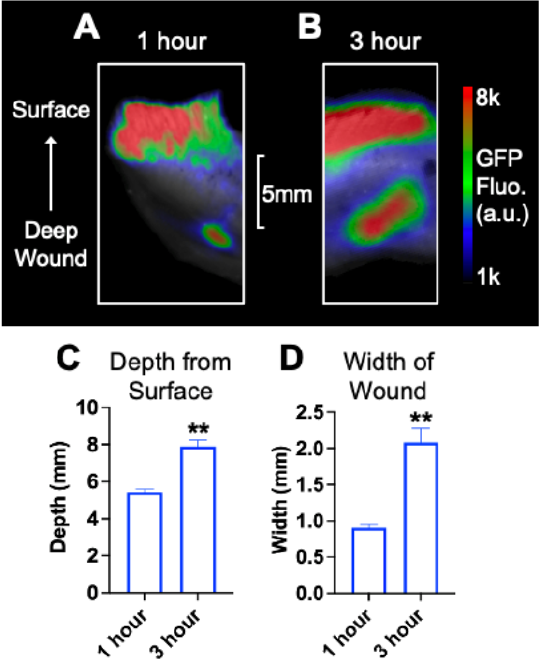
Figure 6. Representative images of deep skin wound tissue after 1 ( A ) and 3 ( B ) hours of initiating infection with GFP- E. coli . Histograms show the quantification of the depth ( C ) and width ( D ) of infection in the skin. n = 3 per group. a.u.: arbitrary units. ** p < 0.01.